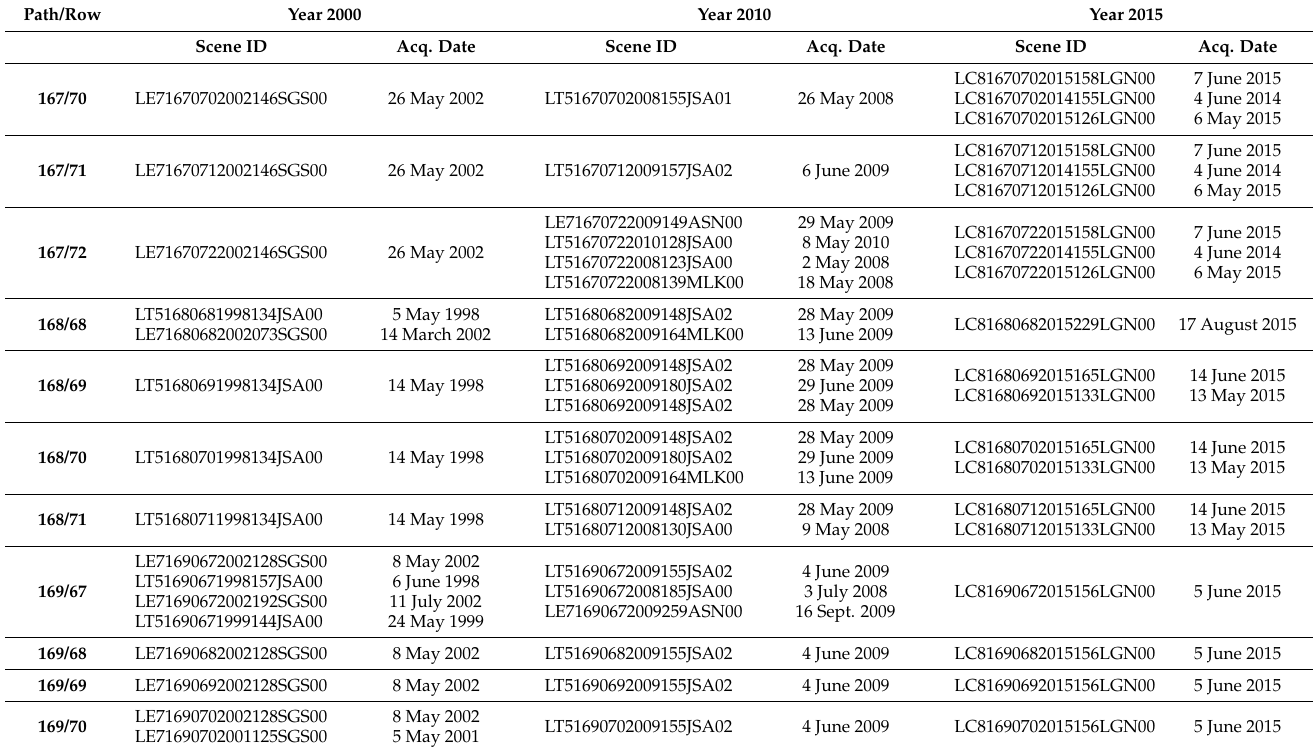
Table 1. Listing of all Landsat path/row combinations, acquisition date and scene identifier for imagery used in this